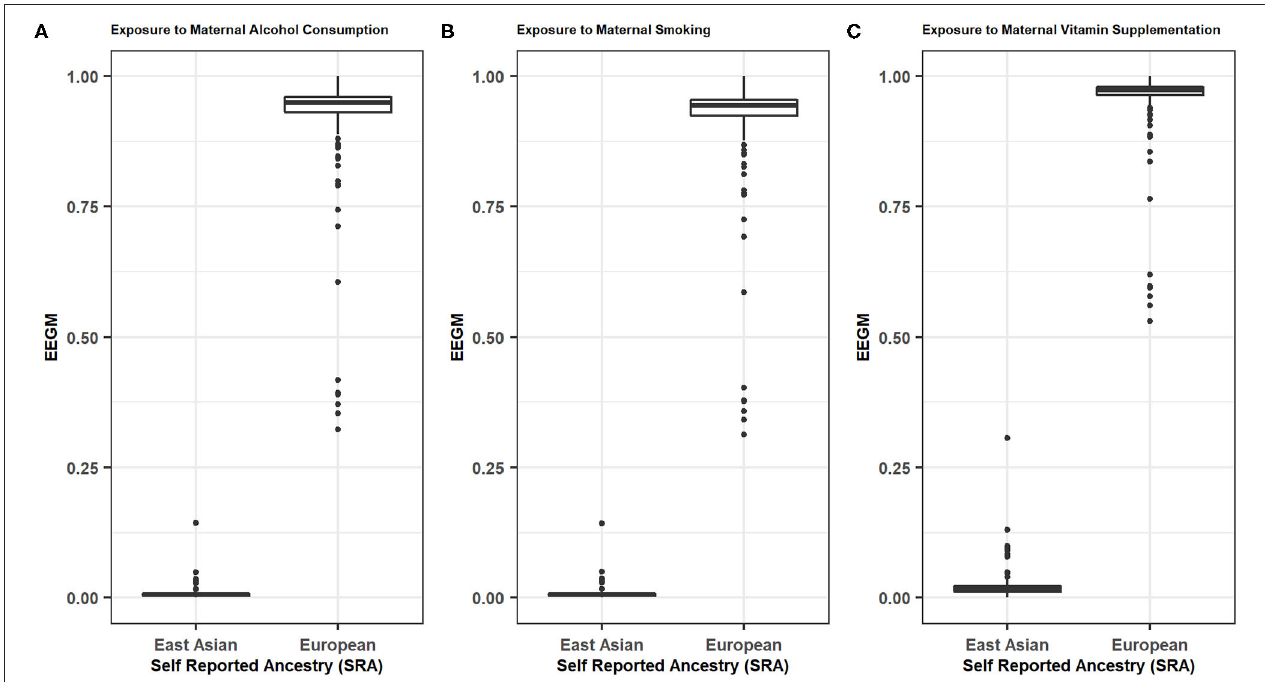
FIGURE 1 | EEGM by SRA for (A) Maternal Alcohol Consumptions, (B) Maternal Smoking, (C) Maternal Vitamin Supplementations.